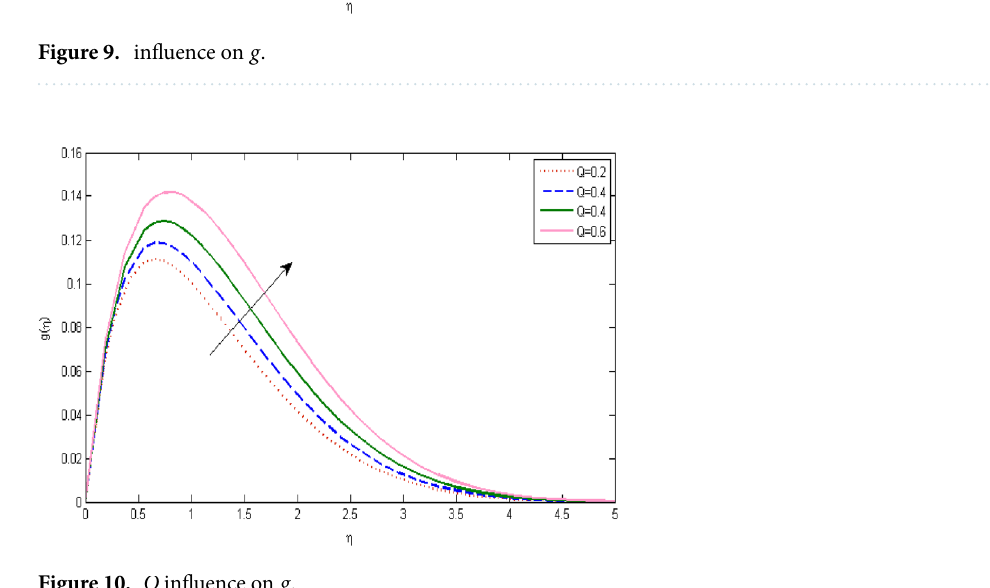
Figure 10. Q influence on g